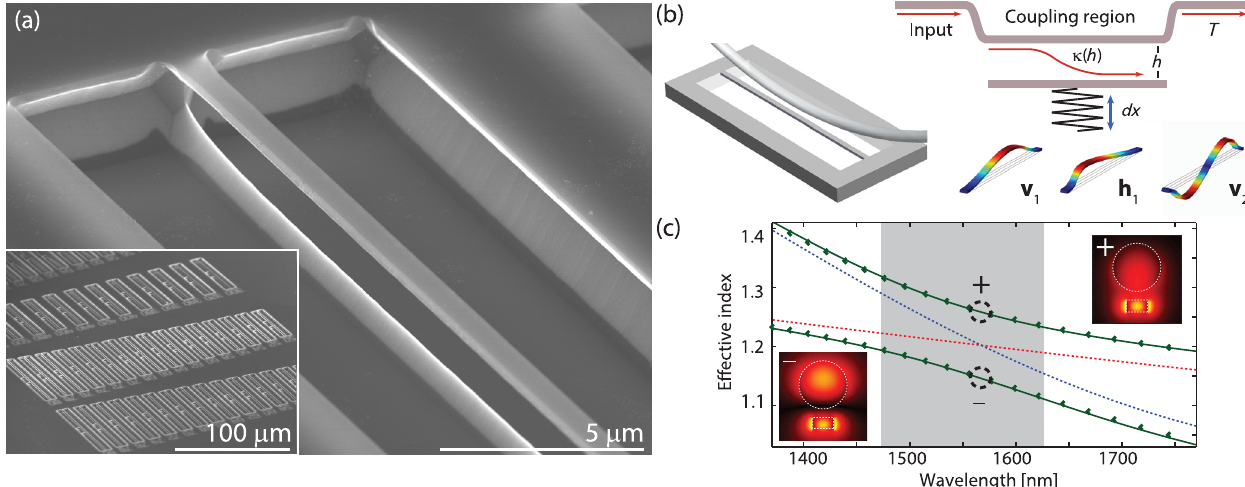
FIG. 1. Diamond nanobeam waveguide-optomechanical system. (a) SEM images of a single-crystal diamond nanobeam waveguide. Dark high-contrast regions are due to variations in thickness of titanium deposited for imaging purposes. (b) Schematic of fiber taper evanescent waveguide coupling geometry and illustration of the waveguide-optomechanical coupling process. Nanobeam mechanical resonances, whose typical displacement profiles are shown, modulate the distance between the input waveguide, changing κ ð h Þ . (c) Dispersion of n of the waveguide modes of the fiber taper (diameter 1 . 1 μ m) and diamond nanobeam ( w × d ¼ 460 × 250 nm 2 ) eff when they are uncoupled (fiber taper shown by red dashed line, nanobeam shown by blue dashed line) and coupled with h ¼ 300 nm (solid lines). Shaded region indicates the laser scan range used in the experiments. Insets: Mode profiles ( x - y plane, dominant electric j ) of the symmetric ( þ ) and antisymmetric ( − ) coupled field component j E y